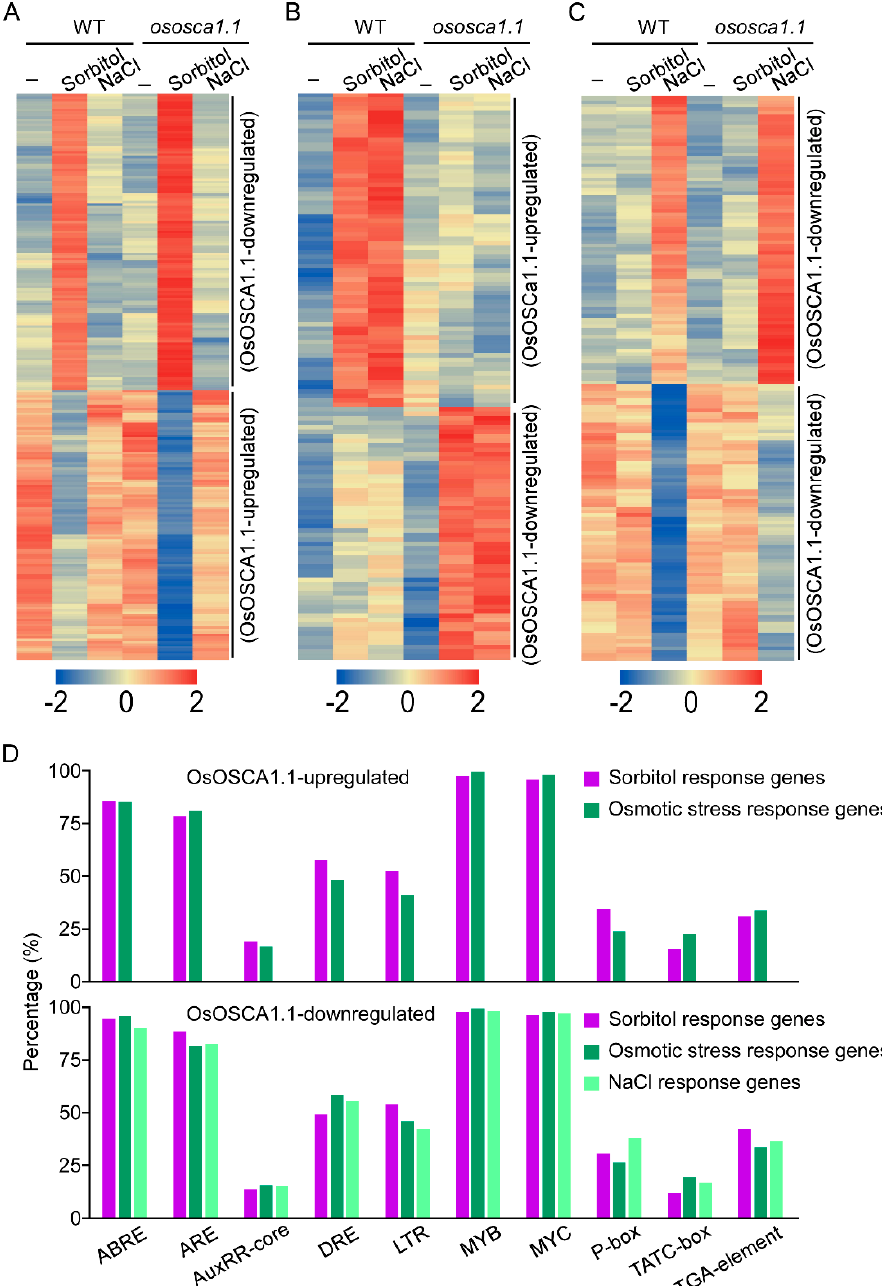
Figure 5. Enriched cis -regulatory elements in the 2000-bp promoter regions of three clustered OsOSCA1.1-regulated genes. ( A – C ) Hierarchical cluster analysis of the OsOSCA1.1-regulated genes in ZH11 and ososca1.1 plants associated with ( A ) sorbitol, ( B ) osmotic stress, and ( C ) NaCl according to Cluster 3.0 software. In each cluster, one row represents one gene; log (FPKM) values of each gene were calculated, and expression patterns are color-coded; red and green indicate high and low expression, respectively. FPKM values for each gene in every cluster are listed in Table S4. The gene expression pattern in each cluster was labeled on the right. ( D ) Different cis -regulatory elements were distributed in the 2000-bp promoter region of 178 OsOSCA1.1-upregulated genes (108 sorbitol response and 70 osmotic stress response), and 336 OsOSCA1.1-downregulated genes (119 sorbitol response, 56 osmotic stress response, and 126 NaCl response). The cis -regulatory elements were predicted using the PlantCARE program. The percentage of every cis-regulatory element distributed in the three types of OsOSCA1.1-regulated genes were